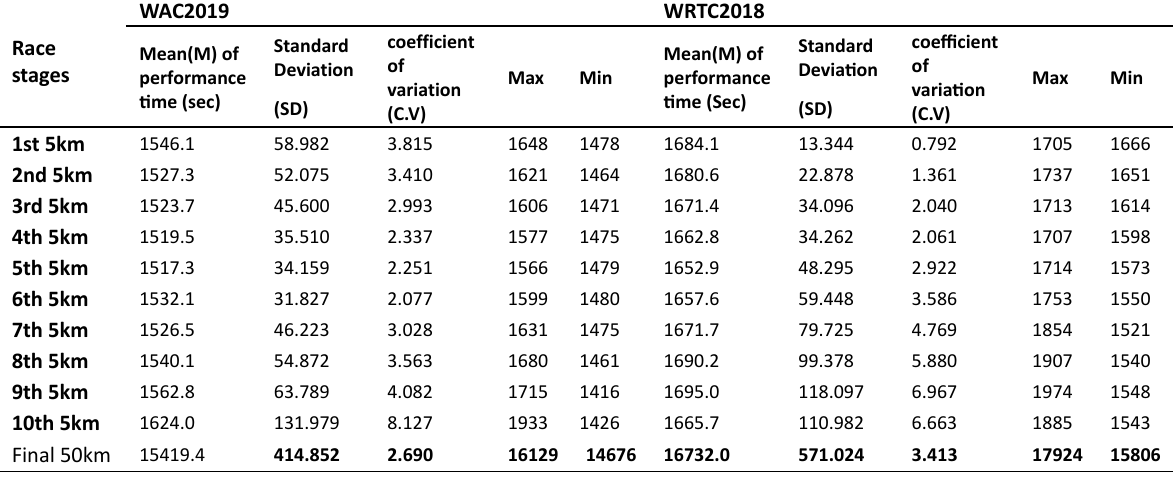
Figure 1 . The performance time of women’s 50km racewalking in relation to their classification position for WRTC2018 b Table 2. Mean (M), Standard Deviation (SD), Coefficient of Variation (C.V), Maximum (Max), and Minimum (Min) of performance time for race stages in both Championships.